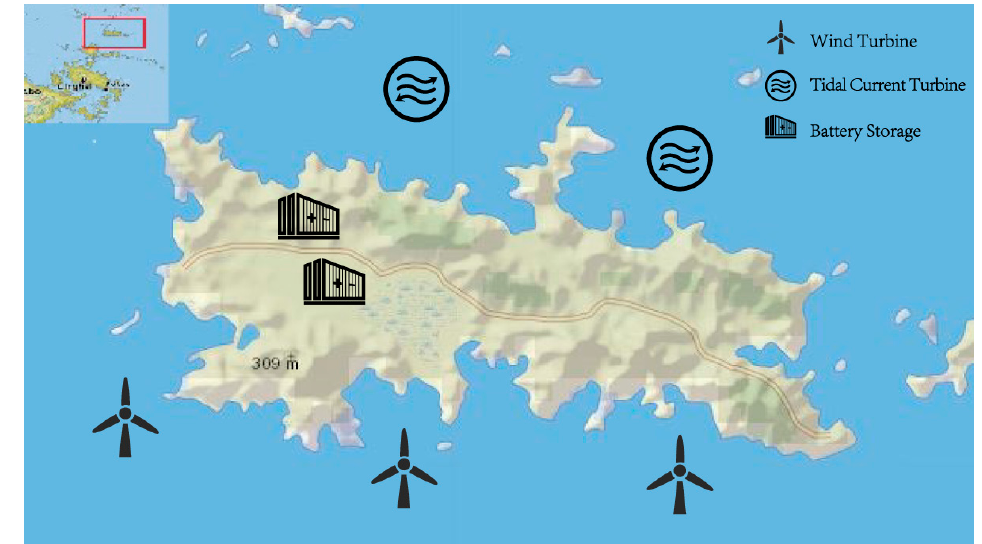
Figure 2. The map of the studied site in Zhoushan Archipelago.